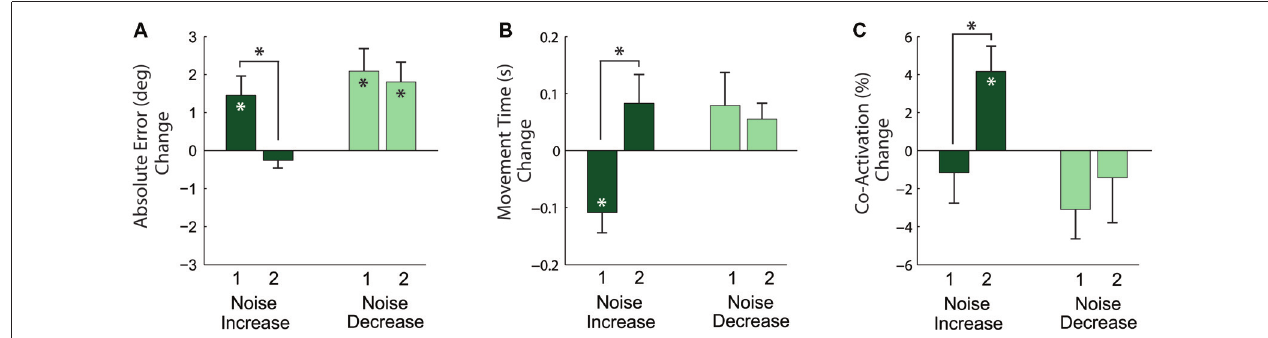
FIGURE 7 | Changes in task performance, quantified by the absolute angular error (A), movement time (B), and antagonistic co-activation (C) with increased (dark green bars) and decreased (light green bars) motor noise. Each bar represents the change relative to a preceding block of non-manipulated trials. Measures significantly different from zero denoted by ( ∗ ), measures that differ across manipulation blocks 1 and 2 denoted by connecting lines with ( ∗ ) above. Error bars represent the standard